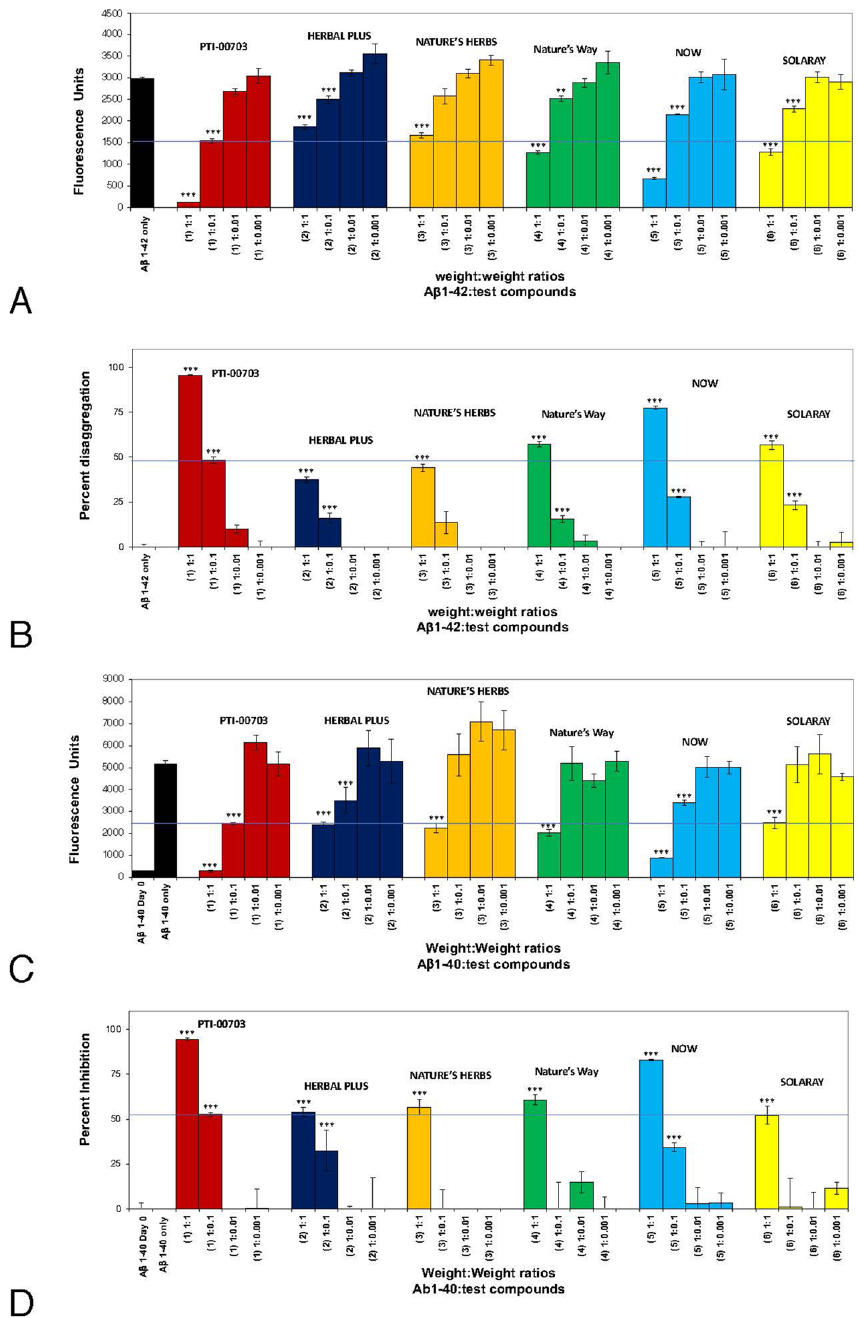
Figure 10. Comparison of PTI-00703 Cat’s claw to 5 other cat’s claw extracts. ( A ) Comparisons included cat’s claw from HERBAL PLUS, NATURE’S HERBS, Nature’s Way, NOW, and SOLARAY. PTI-00703 Cat’s claw demonstrated the most robust activity in disrupting/disaggregation of pre-formed Aβ 1–42 fibrils in a dose-dependent manner. At a 1:0.1 wt/wt PTI-00703 Cat’s claw demonstrated a 52.3% disaggregation/dissolution of pre-formed Aβ 1–42 fibrils, whereas the other cat’s claw extracts demonstrated much less activity (less than 20%) at that same dose. *p < 0.05, **p < 0.01, ***p < 0.001, by Student’s t-test. Bars represent mean ± SEM. ( B ) Disaggregation of preformed Aβ 1–42 fibrils by PTI-00703 Cat’s claw in comparison to other cat’s claw extracts. Comparisons were made between PTI-00703 Cat’s claw and cat’s claw extracts from Herbal Plus, Nature’s Herbs, Nature’s Way, NOW, and SOLARAY. At the 1:0.1 wt/wt dose of Aβ 1–42: PTI-00703 Cat’s claw significantly disaggregated Aβ 1–42 amyloid plaque fibrils by 48.6%. The next closest activity to that dose was cat’s claw from the cat’s claw product from NOW, in which there was just a 26.1% disaggregation. *p < 0.05, **p < 0.01, ***p < 0.001, by Student’s t-test. Bars represent mean ± SEM. ( C ) PTI-00703 Cat’s claw is a potent inhibitor of Aβ 1–40 fibril formation. Thioflavin T fluorometry compared PTI-00703 Cat’s claw to other cat’s claw extract (including HERBAL PLUS, NATURE’S HERBS, Nature’s Way, NOW, and SOLARAY) for inhibition of formation of Aβ 1–40 fibrils within a 3-day period. Aβ 1–40 peptide formed amyloid fibrils detected by Thioflavin T fluorometry within 3 days when incubated at 37 °C (black bars). ( D ) At the 1:0.1 wt/wt dose of Aβ 1–40: PTI-00703 Cat’s claw significantly inhibited Aβ 1–40 fibril formation by 52.3%. *p < 0.05, **p < 0.01, ***p < 0.001, by Student’s t-test. Bars represent mean ±